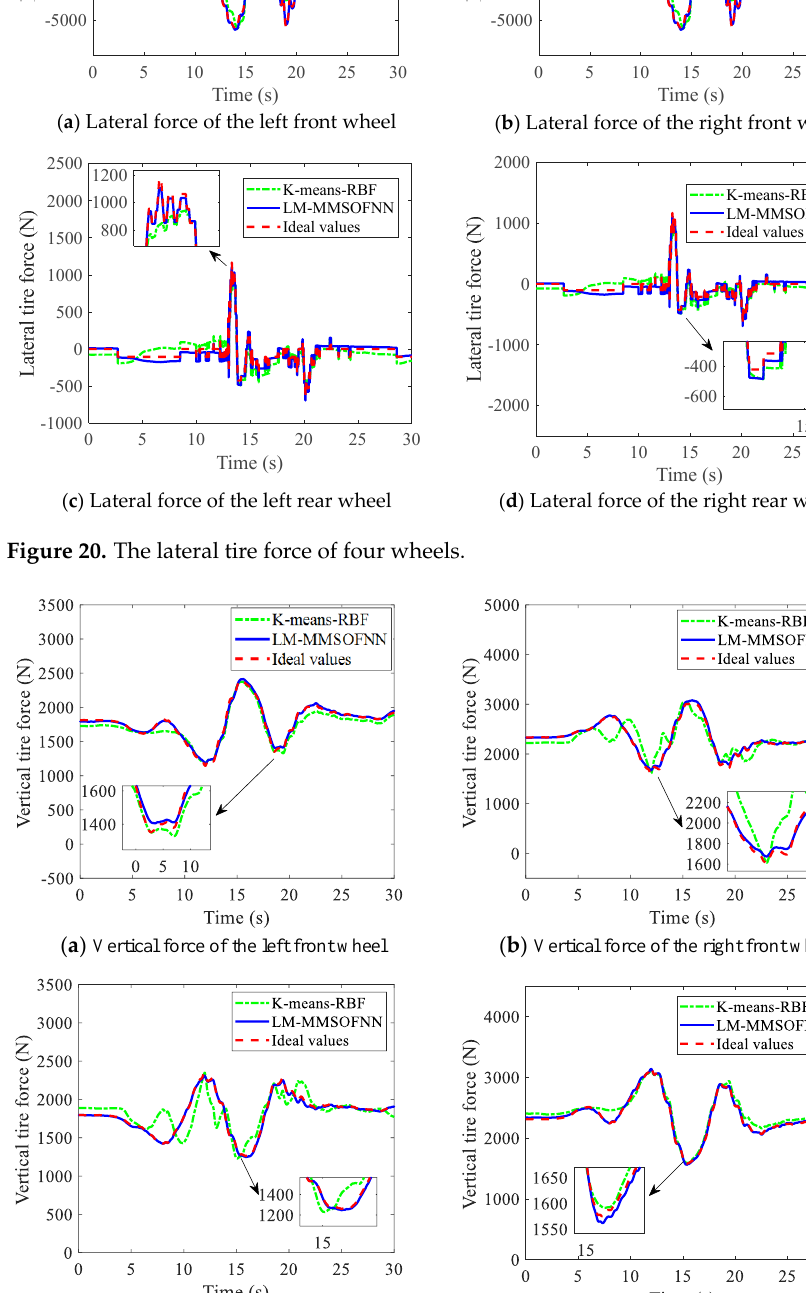
Figure 21. The vertical tire force of four